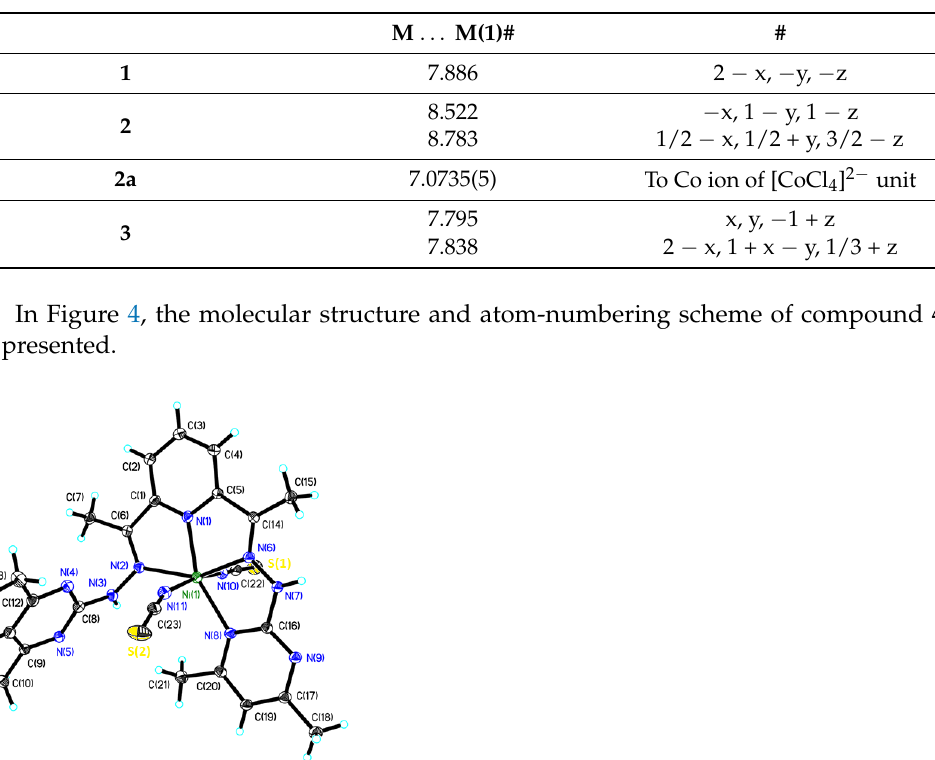
Figure 3. Fragment of the crystal packing in 2 .